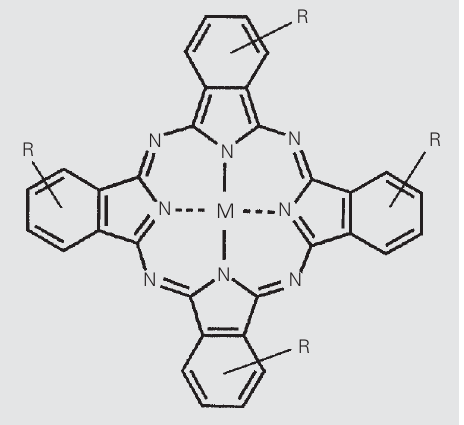
Figure 1. Typical phthalocyanine structure where M is the central metal ion (Al, Zn, Co, Ga, Si) and R represents a multitude of pos- sible ring substituents including SO 3 H, F, COOH,